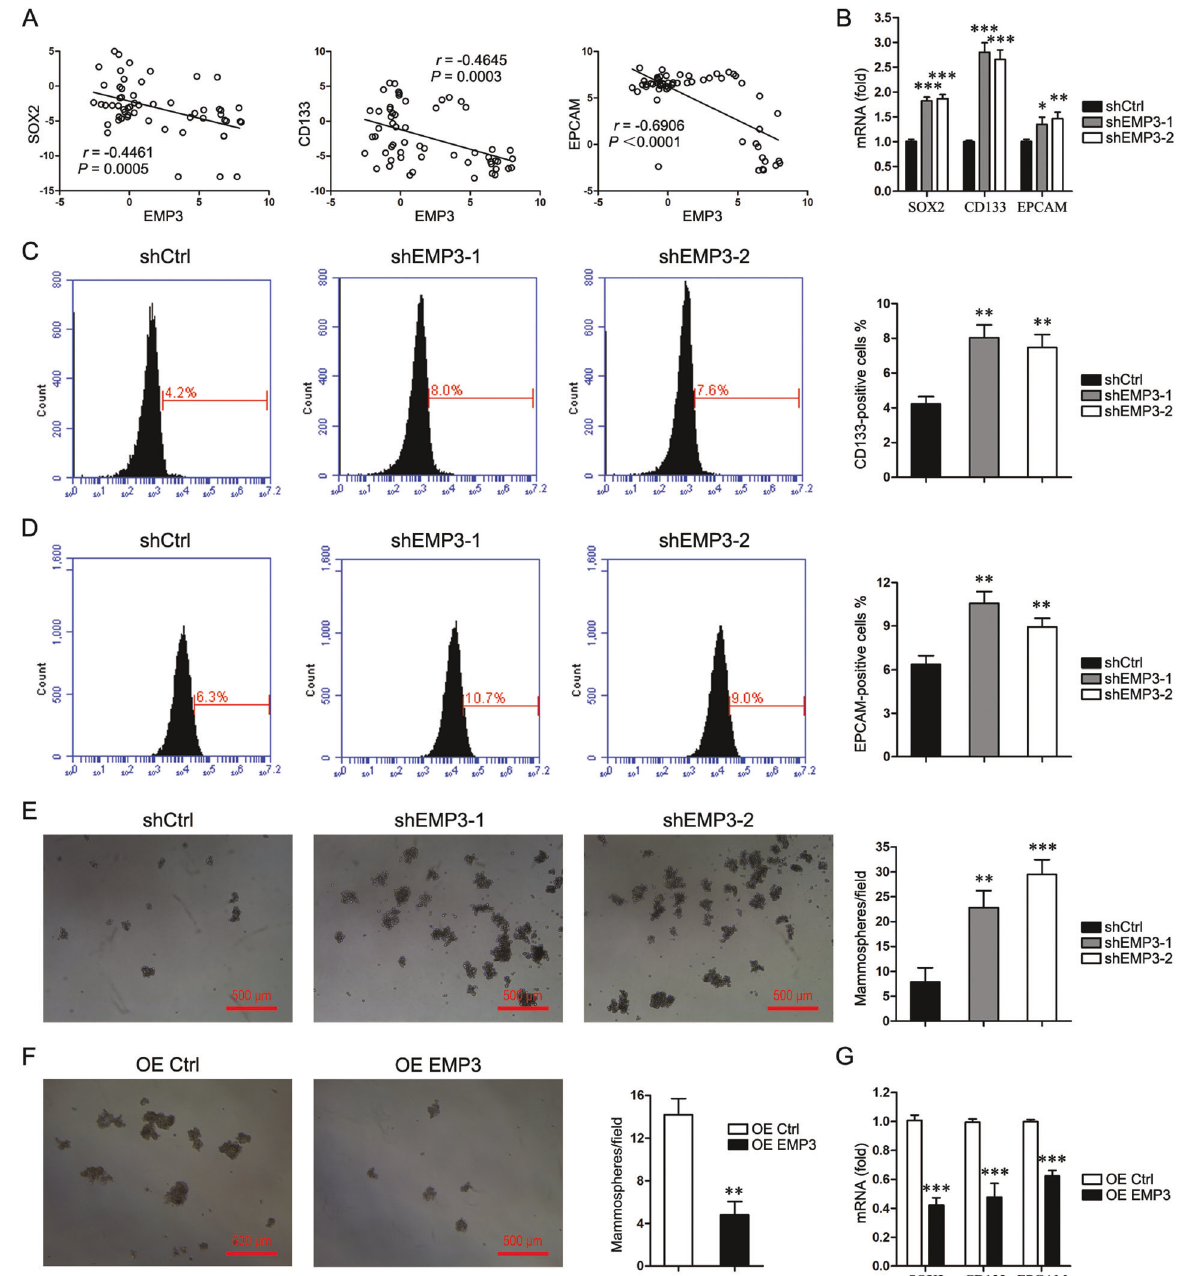
Fig. 4 EMP3 interferes with stem-like properties. A CCLE database was interrogated for EMP3, SOX2, CD133, and EPCAM expression. Correlation between two genes in a total of 57 breast cancer cell lines was analyzed by Pearson statistics. B SOX2, CD133, and EPCAM expression in MDA-MB-231 cells were detected by real-time PCR. Mean ± SD, n = 3. * P < 0.05, ** P < 0.01, *** P < 0.001, vs. shCtrl. C Fractions of CD133-positive MDA-MB-231 cells were detected by fl ow cytometry. Mean ± SD, n = 3. ** P < 0.01, vs. shCtrl. D Fractions of EPCAM-positive MDA-MB-231 cells were detected by fl ow cytometry. Mean ± SD, n = 3. ** P < 0.01, vs. shCtrl. E Mammosphere formation of MDA-MB-231 cells was shown. Mean ± SD, n = 3. ** P < 0.01, *** P < 0.001, vs. shCtrl. F Mammosphere formation of MCF7 cells was shown. Mean ± SD, n = 3. ** P < 0.01, vs. OE Ctrl. G SOX2, CD133, and EPCAM expression in MCF7 cells were detected by real-time PCR. Mean ± SD, n = 3. *** P < 0.001, vs. OE